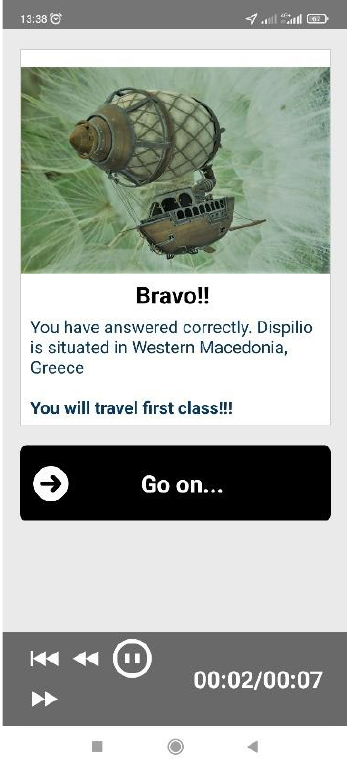
Figure 11. The player gets to travel first class.